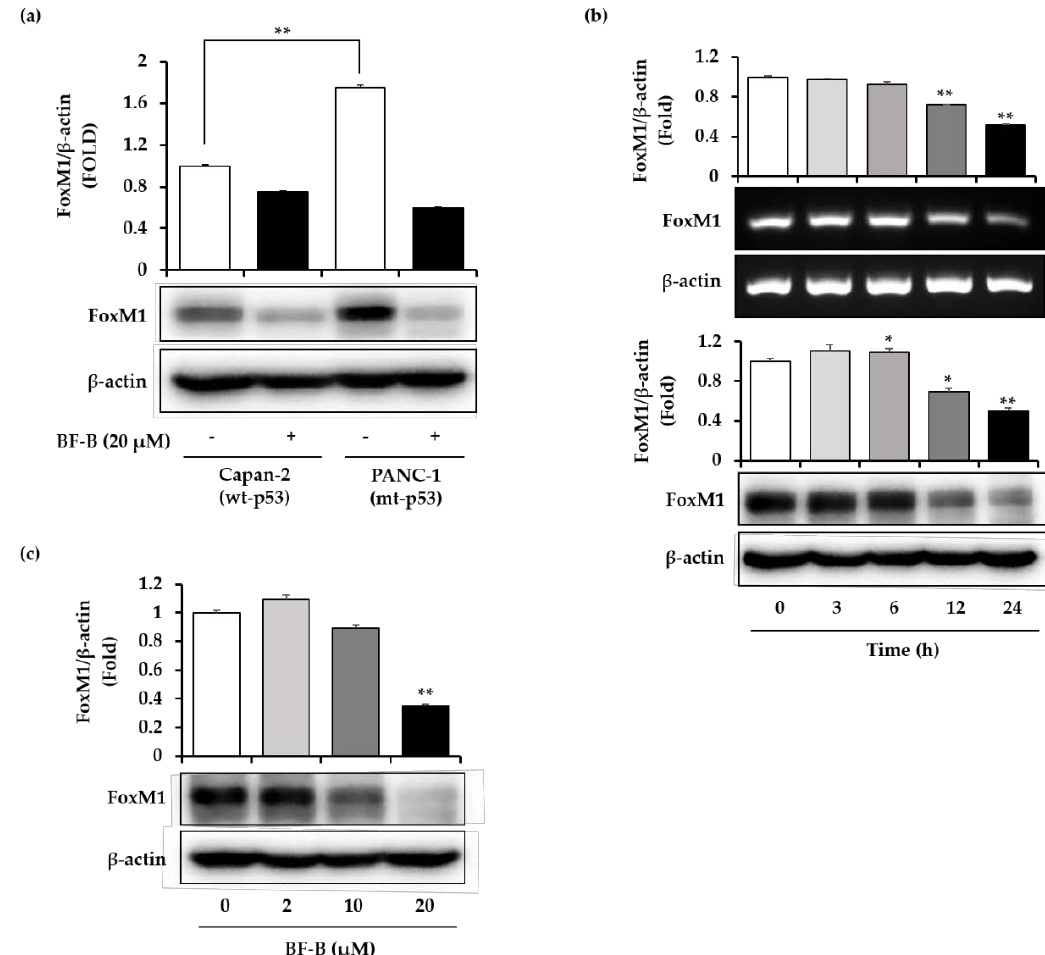
Figure 3. Inhibition of FoxM1 expression by BF-B. ( a ) Human pancreatic cancer cells (Capan-2 and PANC-1) were treated with 20 µ M BF-B for 24 h. The level of FoxM1 was determined by Western blotting. ** p < 0.001 ( b ) PANC-1 cells were treated with 20 µ M BF-B for the indicated times. FoxM1 mRNA was detected by real-time RT-PCR and the FoxM1 protein was detected by Western blotting. * p < 0.01 and ** p < 0.001 as compared to control. ( c ) PANC-1 cells were treated with the indicated concentrations of BF-B for 24 h. FoxM1 protein was detected by Western blotting. The images are representative of three independent experiments with similar results. All data are expressed as means ± SD of three experiments and each experiment included triplicate repeats. ** p < 0.001 as compared to control.